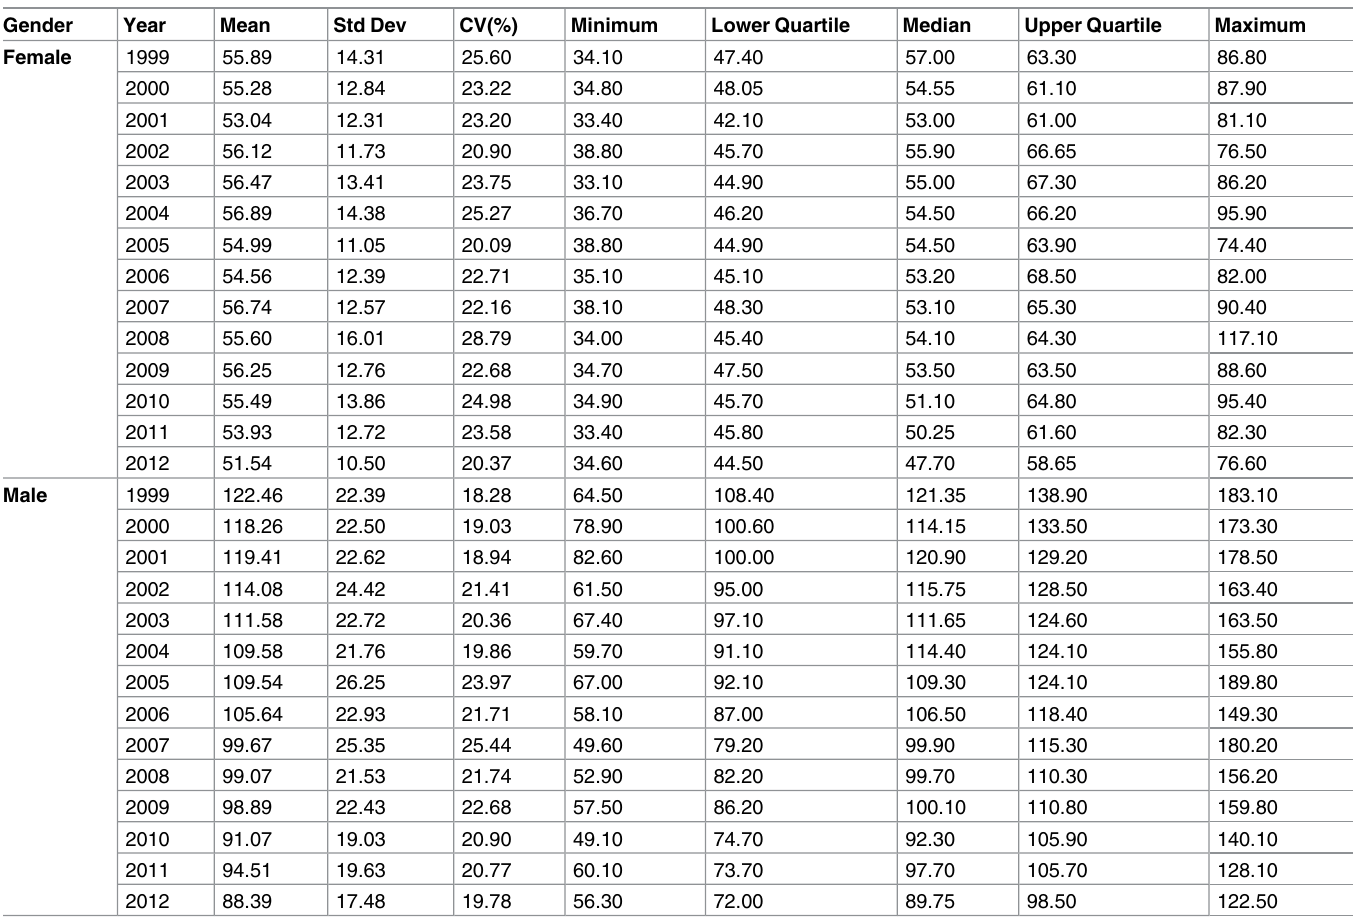
Table 3. Lung cancer incidence rates for Blacks by gender,